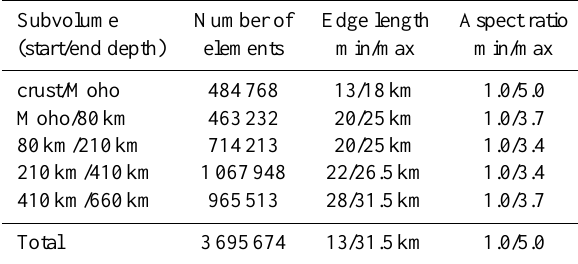
Table 1. Mesh statistics European